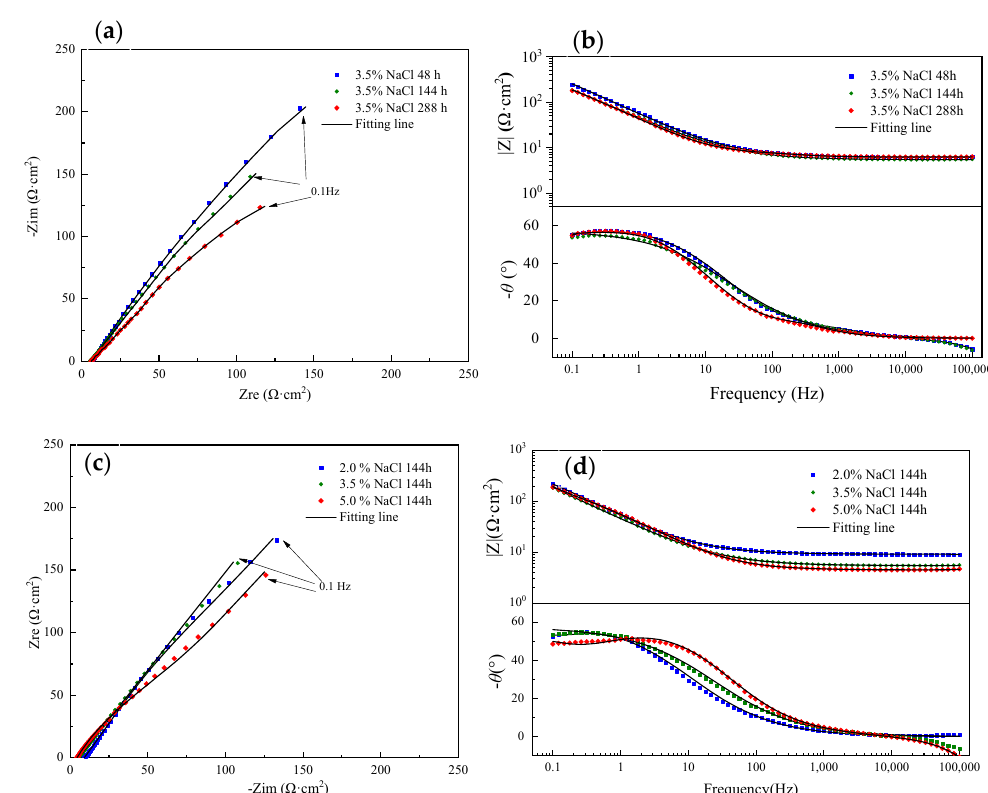
Figure 10. Nyquist plots and Bode plots of specimens tested under different conditions: ( a ) Nyquist plot with immersion time; ( b ) Bode plots with immersion time; ( c ) Nyquist plot with concentration; and ( d ) Bode plots with concentration.